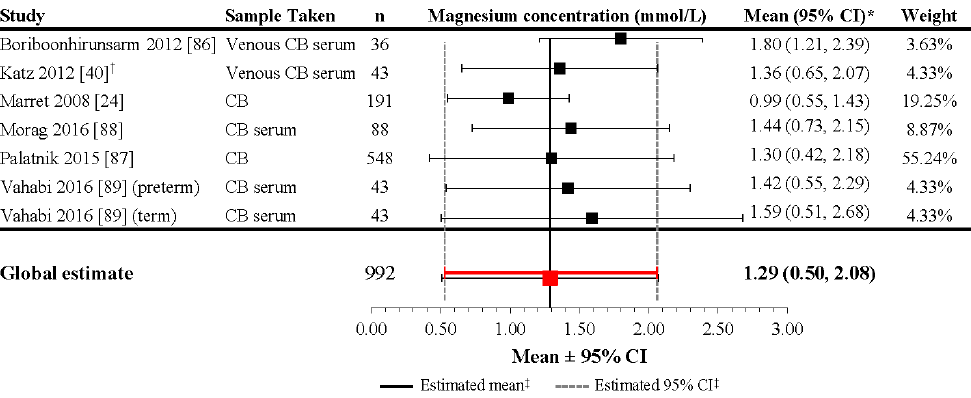
Figure 3. Magnesium concentrations in umbilical cord blood of newborns with magnesium supplementation during pregnancy. * If 95% CIs were not reported in the study, then the 95% CIs were calculated as follows: mean ± (1.96 × SD). † Patient groups within these studies were pooled, as the literature search did not confirm an association between magnesium levels and gestational age, birth weight, or mode of delivery. ‡ Reference line and 95% CI derived using only studies reporting both mean and SD data. Overall statistic for heterogeneity: I 2 = 99.1% ( p < 0.001). CB: [umbilical] cord blood; CI: confidence interval; n: number of infants; SD: standard deviation.